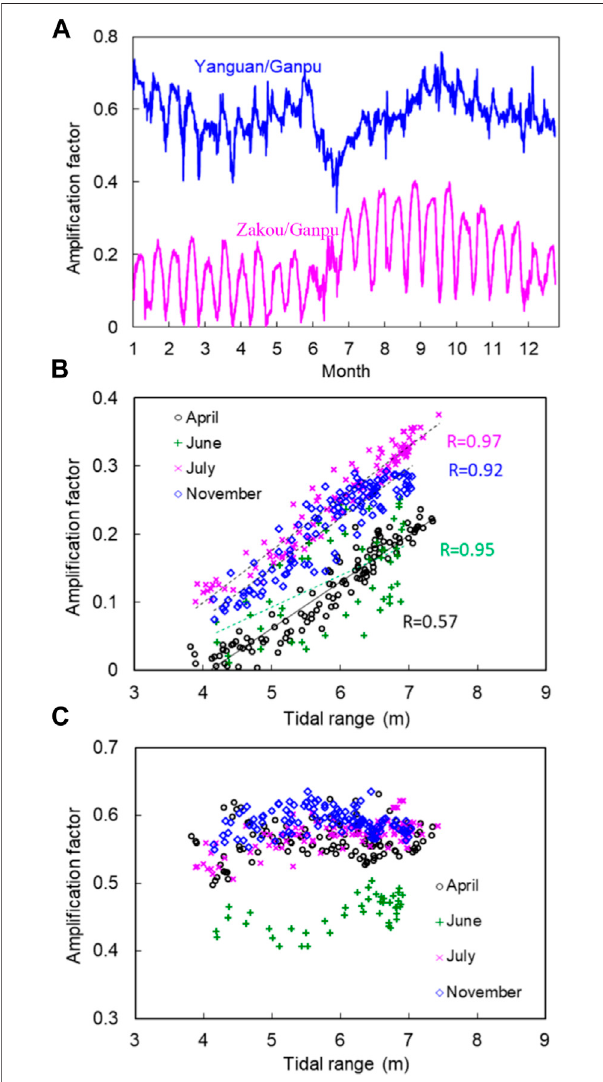
FIGURE 8 | Time series of tidal ampli fi cation factors at Zakou and Yanguan (A) , and their relationships with the tidal range at Ganpu (B, C) .